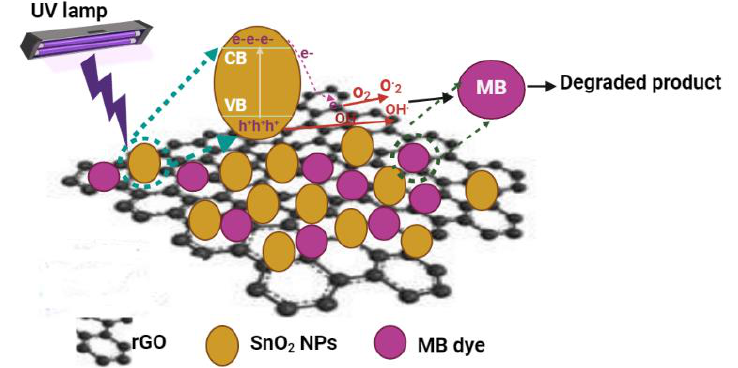
Figure 12. Photocatalytic mechanism for the degradation of MB dye by the SnO 2 -rGO NCs.